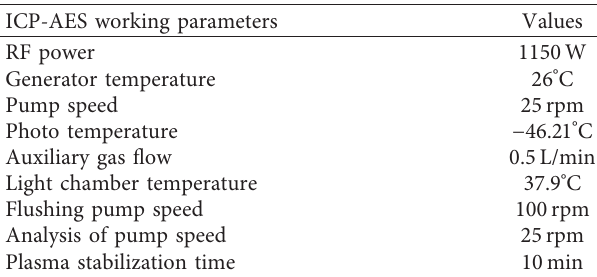
Table 3: Working parameters of ICP-AES instrument. ICP-AES working